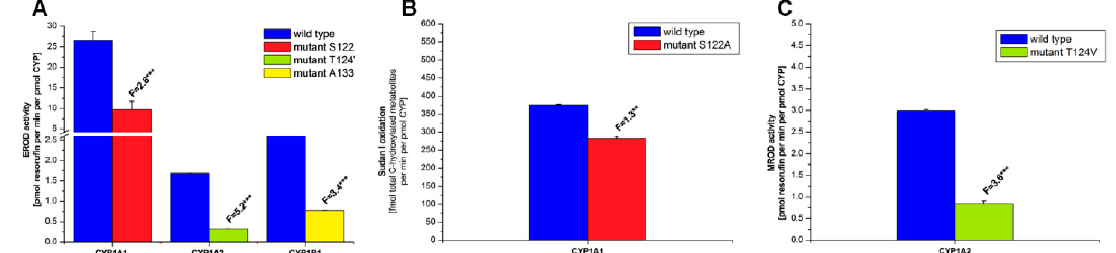
Figure 4. EROD ( A ), Sudan I oxidation ( B ) and MROD ( C ) catalyzed by human wild-type CYP1A1, 1A2 and 1B1, or their mutants CYP1A1-S122A, CYP1A2-T124V, and CYP1B1-A133S. All CYPs were reconstituted with rat POR in a ratio of 1:1 in liposomes. Data are averages ± SD of three independent measurements ( n = 3). Numbers above columns (“F”) indicate fold changes in enzyme activity catalyzed by wild-type and mutant CYPs. Comparison was carried out by Student t -test; ** p < 0.01, *** p < 0.001, different from wild-type CYP enzymes.